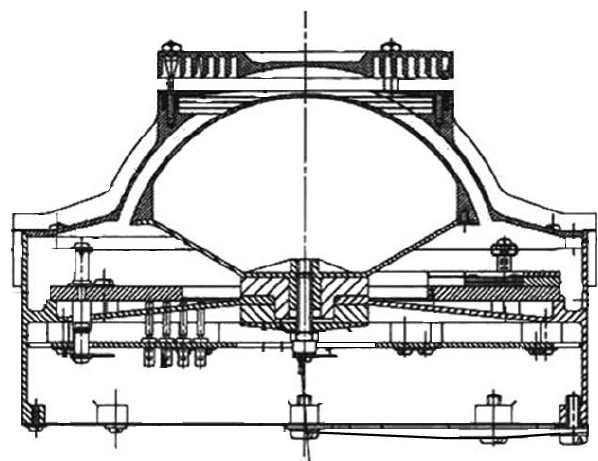
Figure 4. Cross section through a PEACE Sensor electrostatic analyser Fig. 4. Cross section through a PEACE Sensor electrostatic anal-